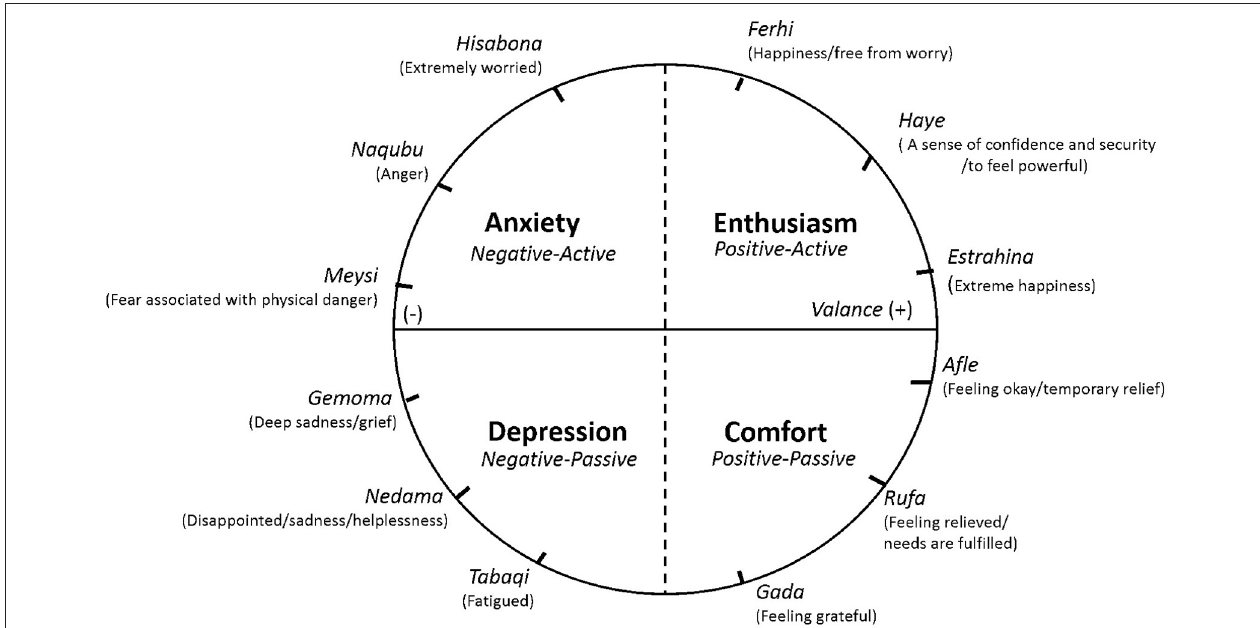
FIGURE 1 | Framework of Afar words for emotion used in the emotion indicator and their meaning [first published by authorship team in Cooper et al. (2019)].